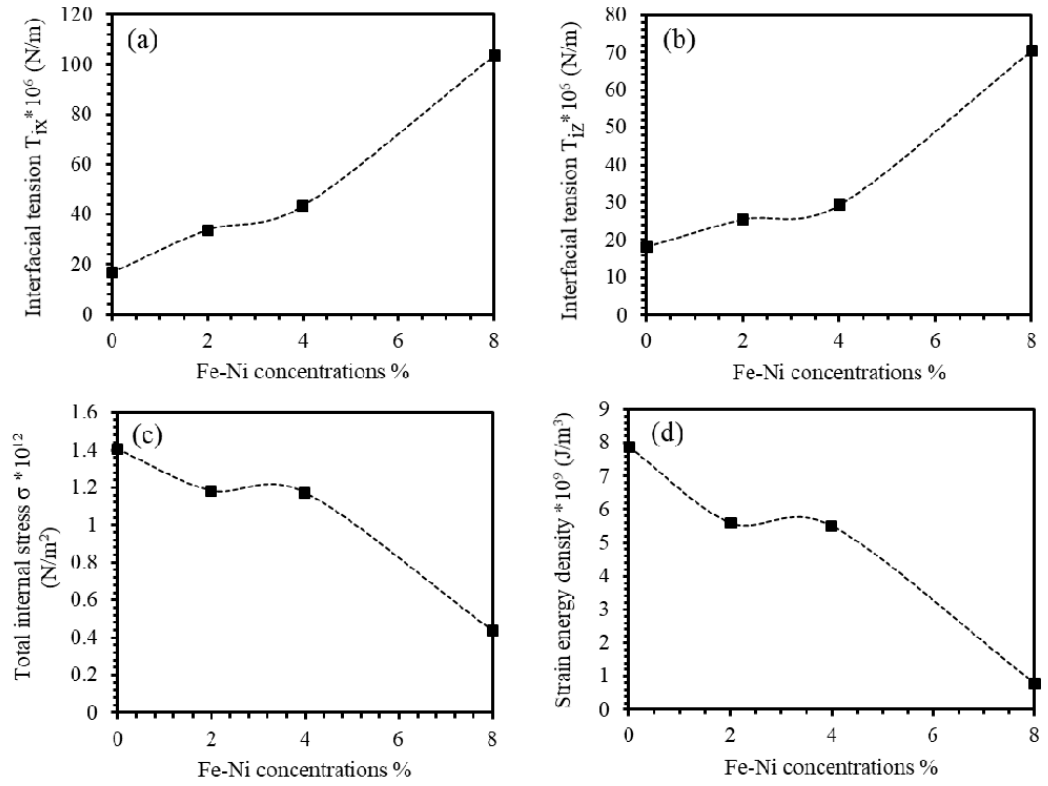
Figure 5. ( a ), ( b ) Interfacial tensions, ( c ) total internal stress, and ( d ) strain energy density of undoped ZnO and (Fe-Ni) co-doped ZnO thin films as a function of (Fe-Ni) concentration.